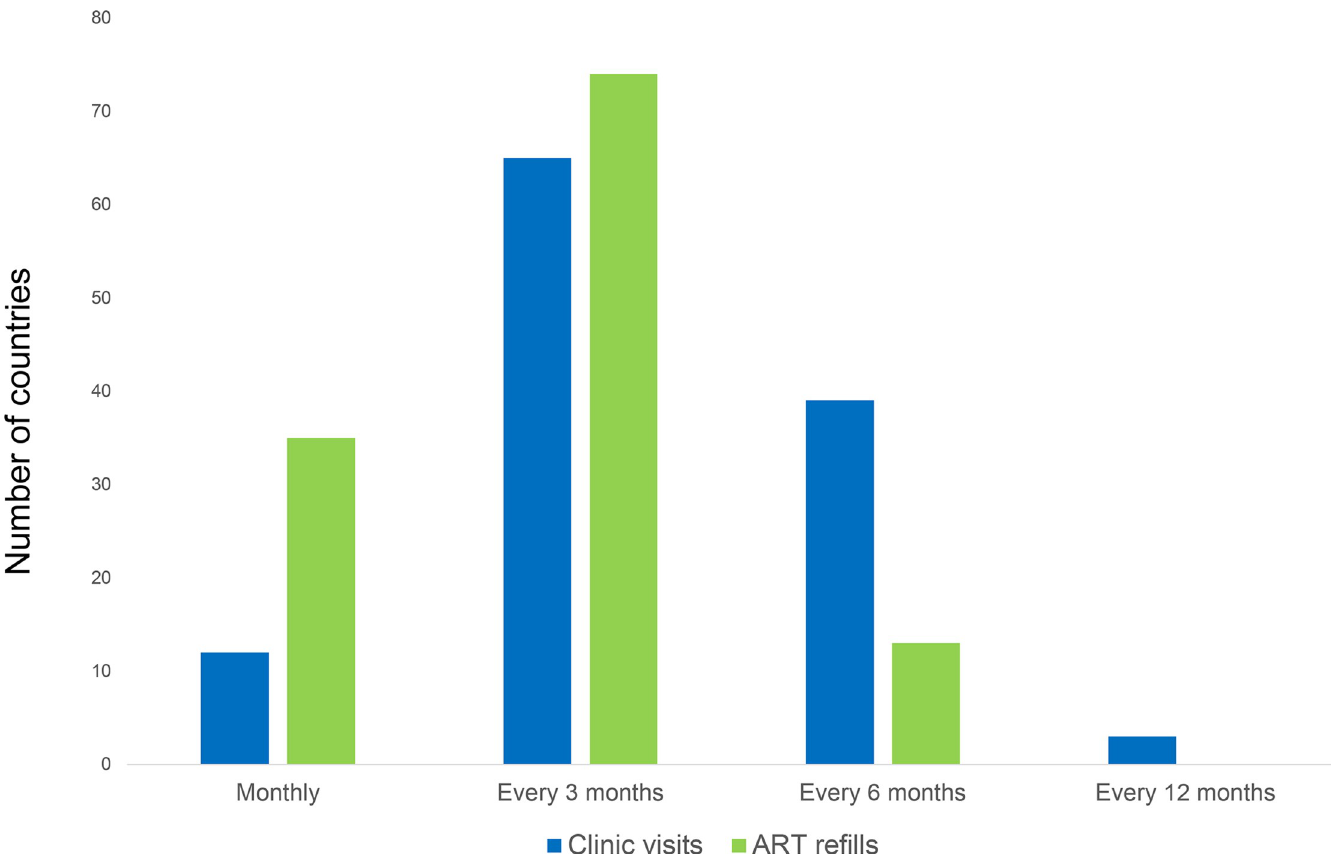
Fig 1. Country policies on the frequency of clinic visits and drug refills for people who are stable on ART. Data from UNAIDS, 2019: http://lawsandpolicies.unaids. org/ ART, antiretroviral therapy.